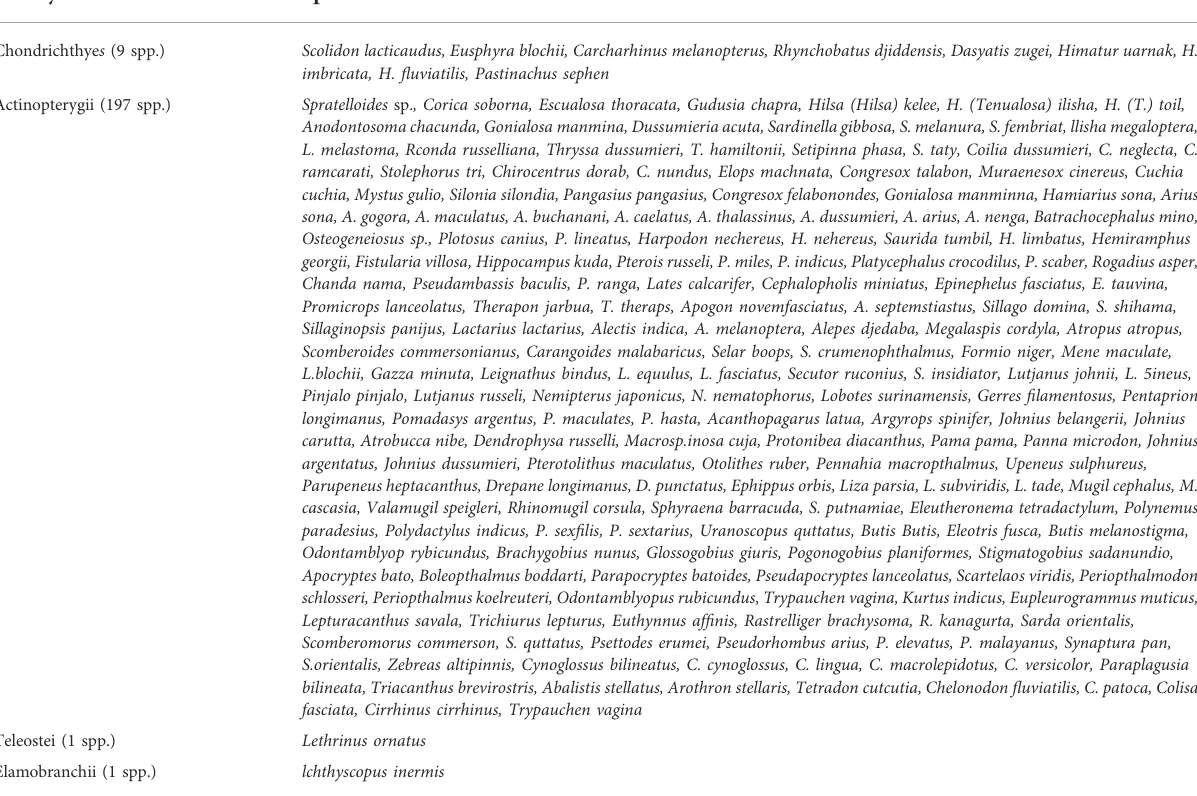
TABLE 9 Diversity of fi sh (208 spp.) in the estuarine waters of Bangladesh. Family Species Chondrichthye s (9 spp.) Scolidon lacticaudus, Eusphyra blochii, Carcharhinus melanopterus, Rhynchobatus djiddensis, Dasyatis zugei, Himatur uarnak, H. imbricata, H. fl uviatilis, Pastinachus sephen Actinopterygii (197 spp.)